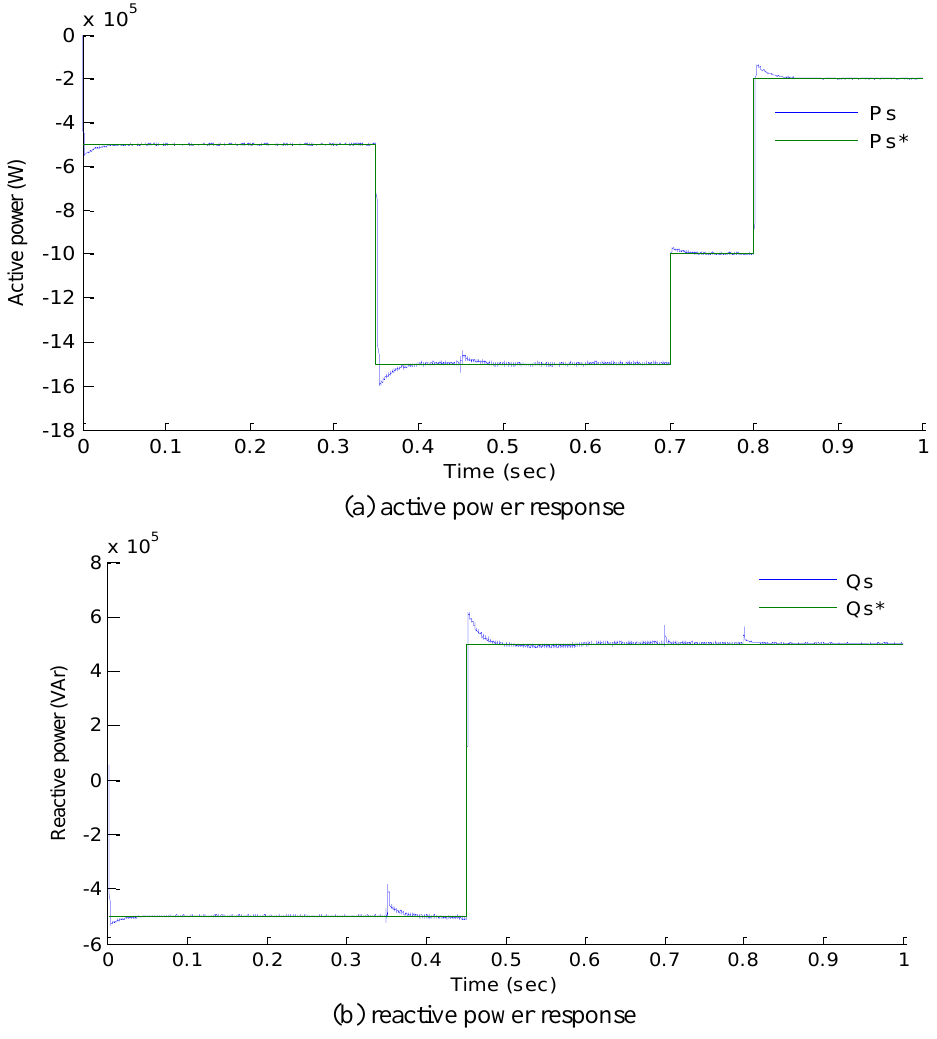
Figure 6. Simulation results of the robustness test against parameters variations of DFIG for the